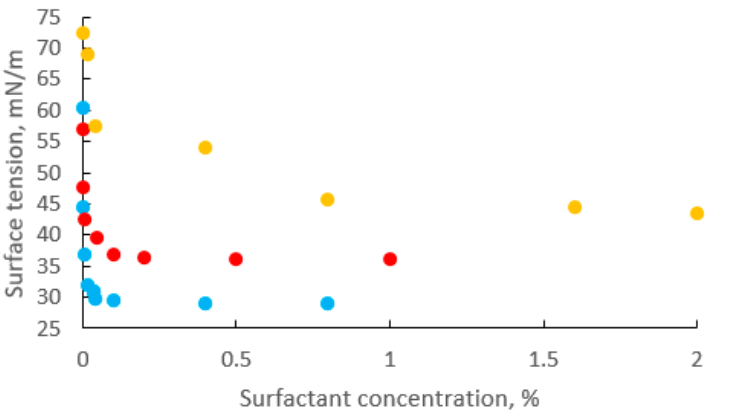
Figure 3. Surface tension values at various concentrations of rhamnolipid biosurfactant (blue), sophorolipid biosurfactant (red), and Ultraplex surfactant (yellow).